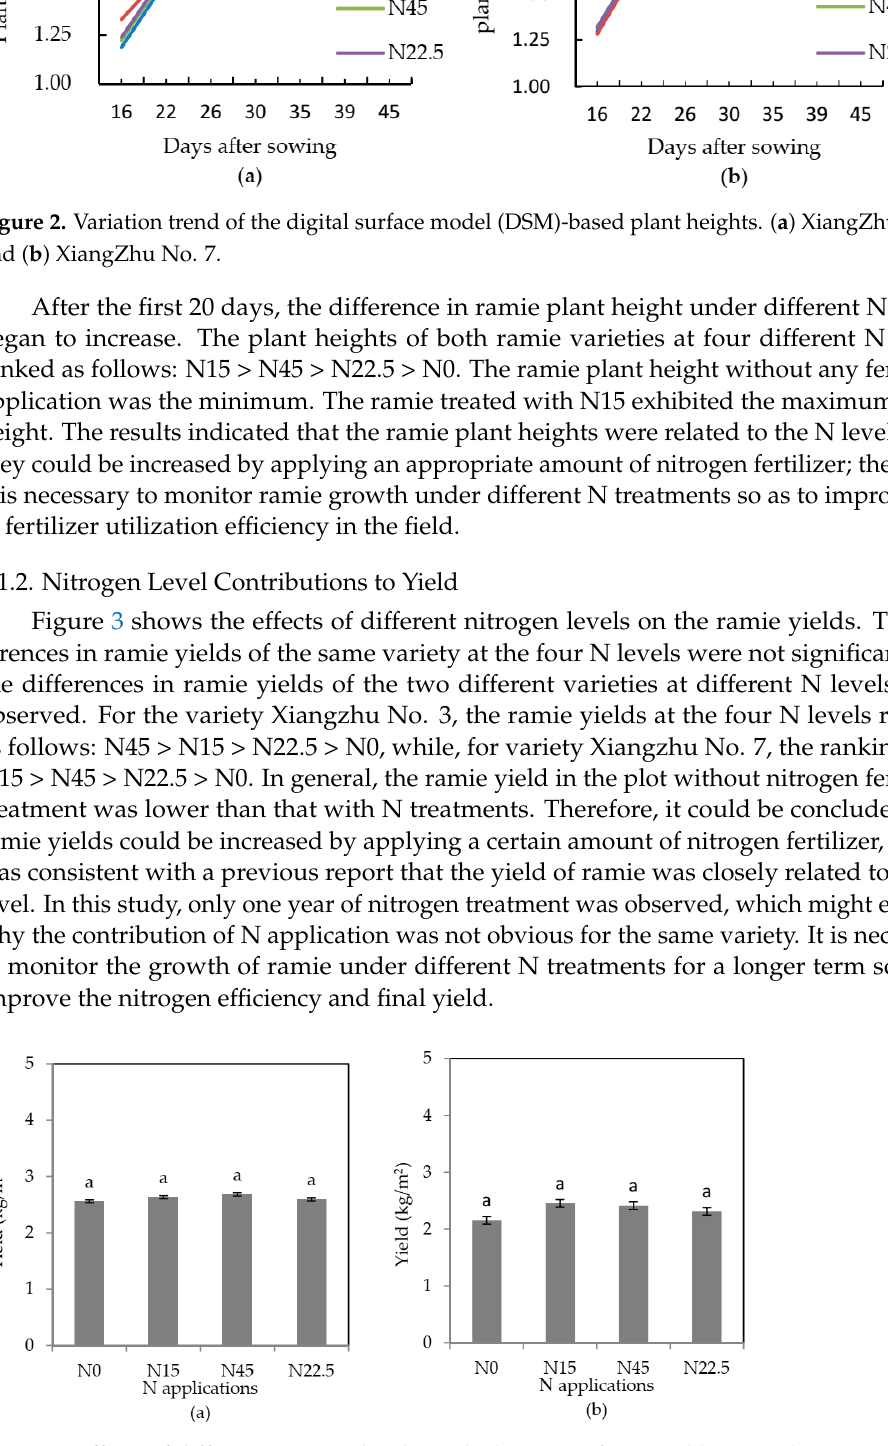
Figure 3. Effects of different nitrogen levels on the biomass of ramie. ( a ) XiangZhu No. 3 and ( b ) XiangZhu No.